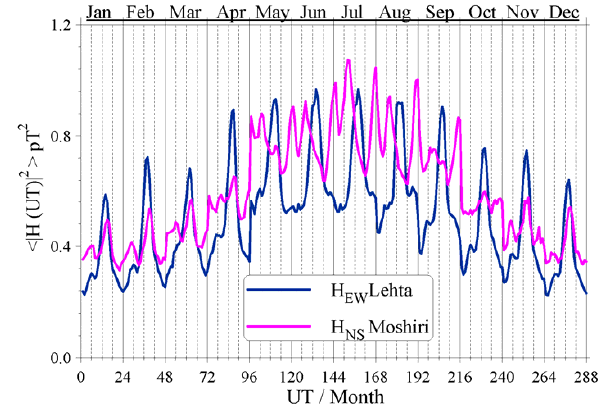
Fig. 6. Experimental data of H EW component at Lehta and the H NS field at